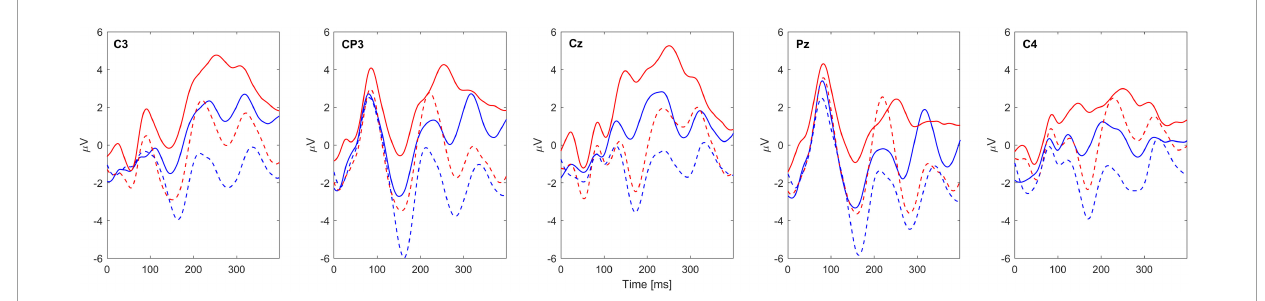
FIGURE3 Grand-average sERP waveforms of subject 2 for 5 EEG channels. Blue lines represent the sERPs associated with stimulation of the radial nerve (D location), while the red lines represent the sERPs associated with stimulation of the median nerve (V location). The solid line represents the attended condition while the dashed line represents the unattended condition. Channel labels are given within each subplot. Zero marks the stimulus onset.